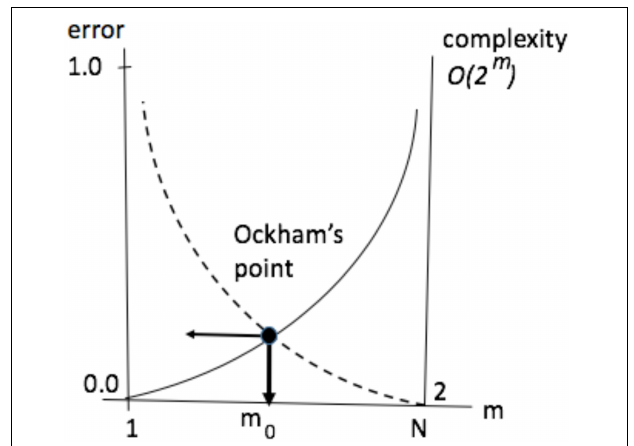
FIGURE 4 | Self-partitioning in the neuronal pool radically impacts pool’s capacities in responding to world streams and involves trade-offs between time and accuracy, as a function of group size. The relationship is non-linear, creating long tail areas where, on the one side, sacrificing speed (increasing the number of groups) produces no appreciable improvements in accuracy (“useless details”) and, on the other side, small speed gains produce quickly increasing errors (“useless generalities”). A narrow inflection zone (Ockham’s point, or O -point) lies between the tail